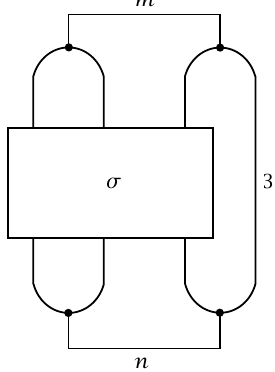
Figure 5.1 . The singular set of θ(σ,m,n)